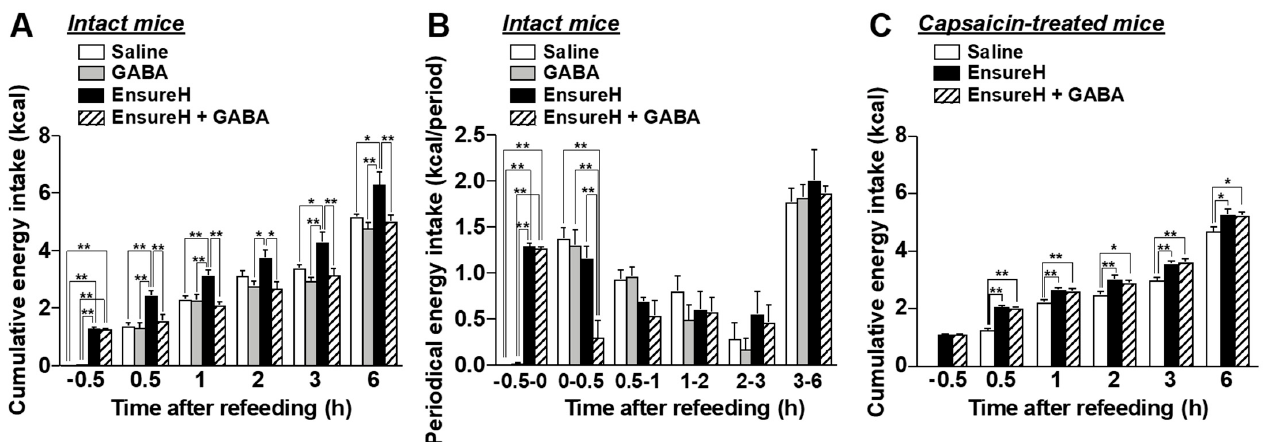
Figure 7. The coadministration of liquid diet EnsureH and GABA markedly prevents overeating through sensory nerves including vagal afferents. ( A , B ): Po administration of only GABA (200 mg/kg, 40 mL/kg) 30 min before refeeding, compared with saline (40 mL/kg, po), did not alter food intake in intact mice fasted overnight. The preadministration of only EnsureH (40 mL/kg) by oral gavage 30 min before refeeding did not alter food intake ( B ), thereby increasing cumulative food intake and inducing overeating until 6 h after refeeding ( A ). The coadministration of EnsureH (40 mL/kg) and GABA (200 mg/kg) markedly suppressed food intake for 0–0.5 h after refeeding ( B ) and thereby prevented overeating ( A ). n = 5–6. ( C ): In capsaicin-treated mice, the simultaneous administration of EnsureH (40 mL/kg) and GABA (200 mg/kg) failed to decrease food intake. n = 11. * p < 0.05, ** p < 0.01 by one-way ANOVA followed by Tukey’s test. GABA: Gamma-aminobutyric acid.